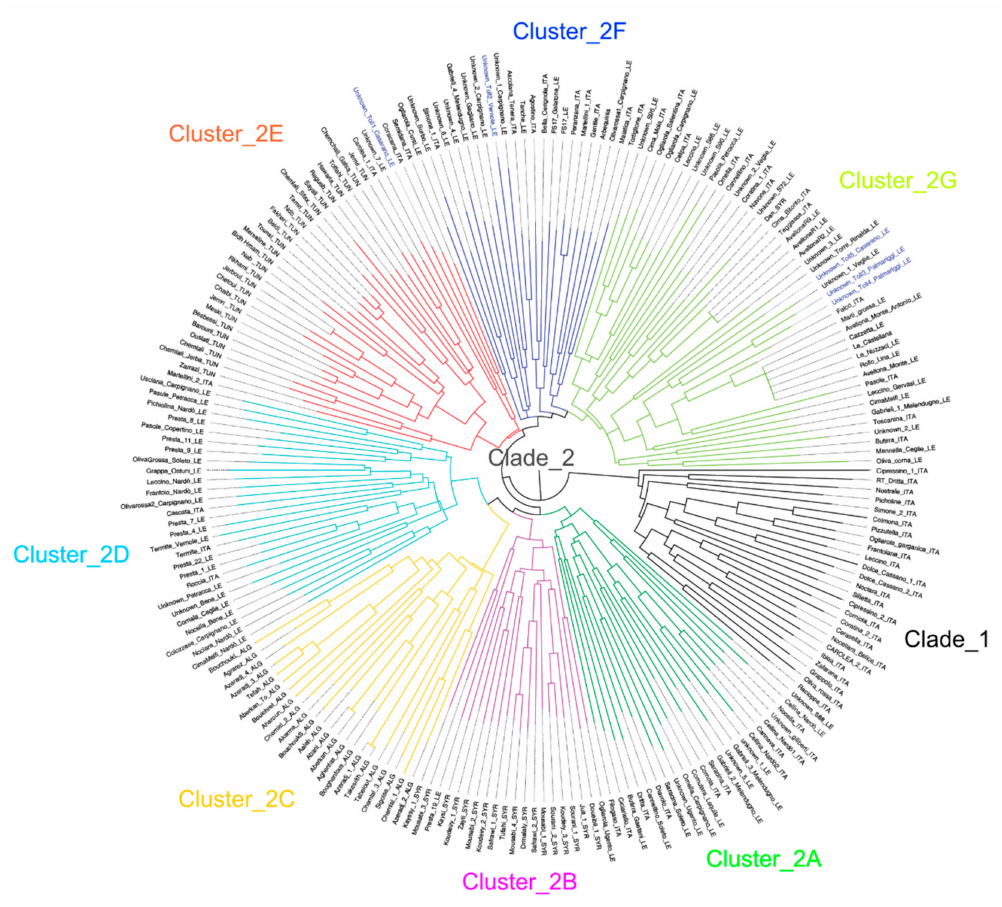
Figure 5. A dendrogram generated by neighbor-joining clustering, illustrating phylogenetic relationships among 218 olive accessions assessed using the SSR markers. The colors of the clades reflect those assigned to STRUCTURE and DAPC clusters. The blue labels indicated five unknown-toll accessions asymptomatic to the OQDS